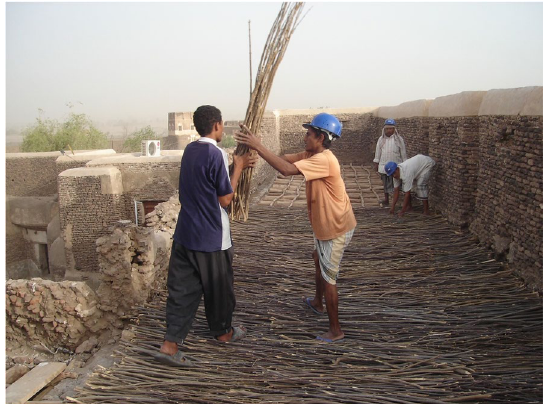
Fig. 5 Zabid, traditional roofing with brushwood (Source: the